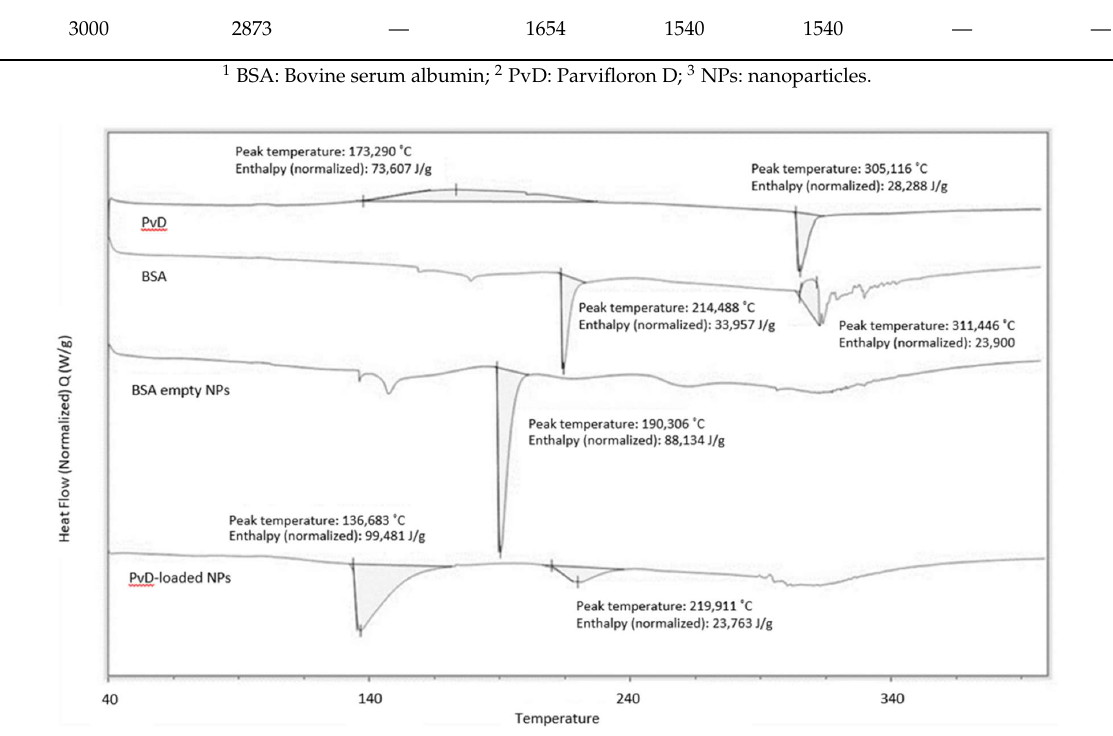
Figure 8. Differential Scanning Calorimetry (DSC) thermal transformations in free Parvifloron D, bovine serum albumin polymer, albumin empty nanoparticles and Parvifloron D-loaded nanoparticles, respectively. The major peak temperatures (°C) and the difference in Gibbs energy (J/g), for each sample, are also represented.